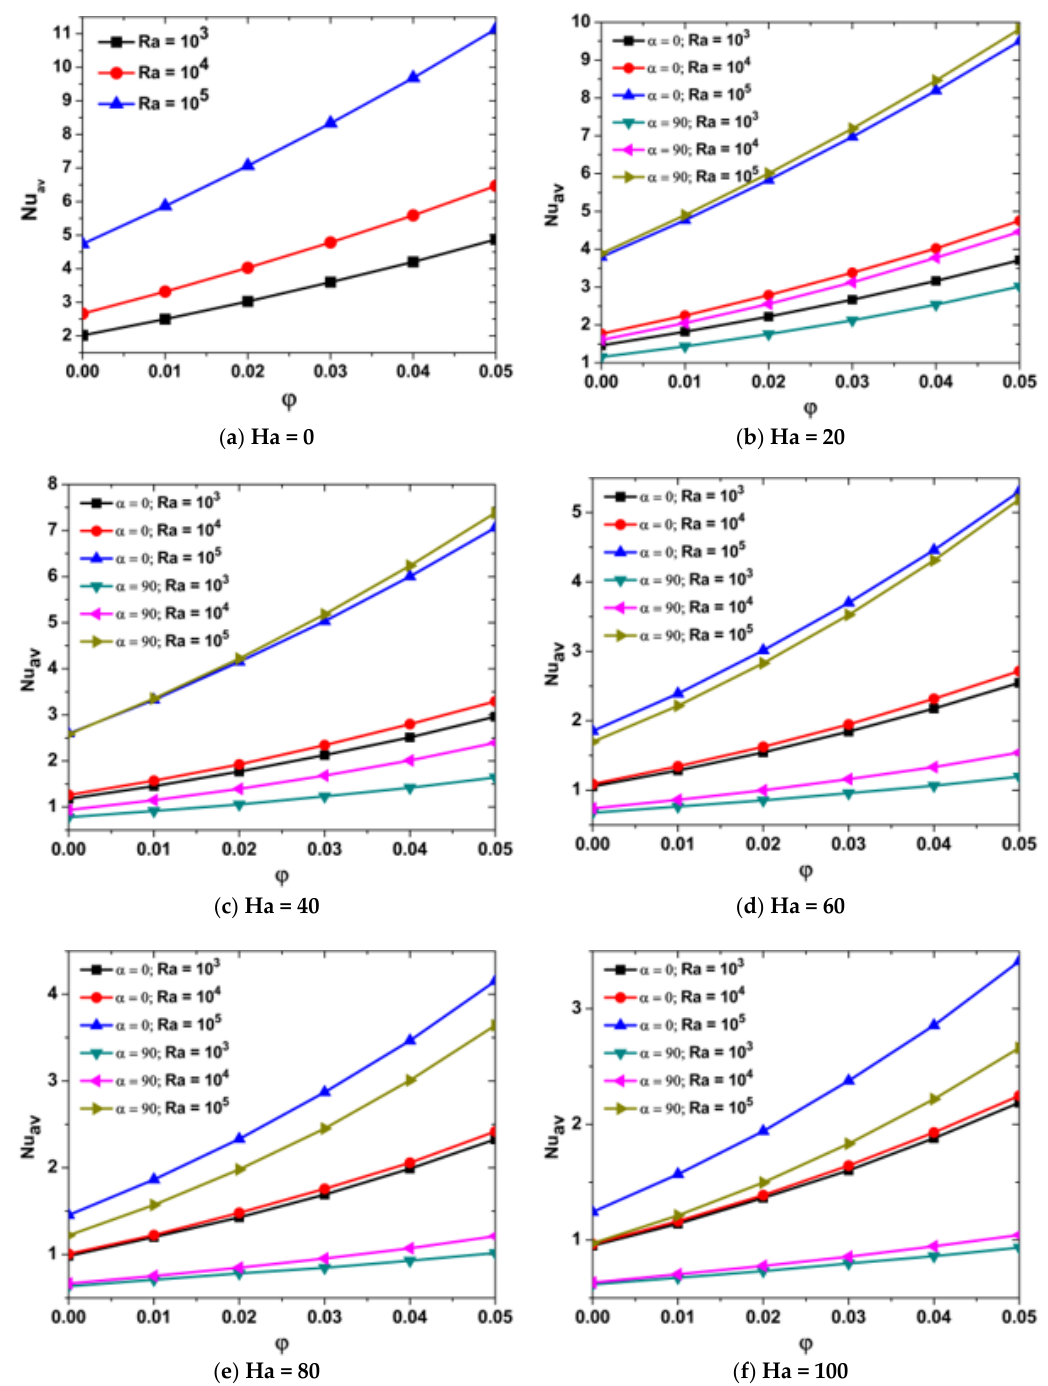
Figure 7. Effects of CNT volume fraction and Hartmann number on the mean Nusselt number with Ma = 1000 and different Ra number.